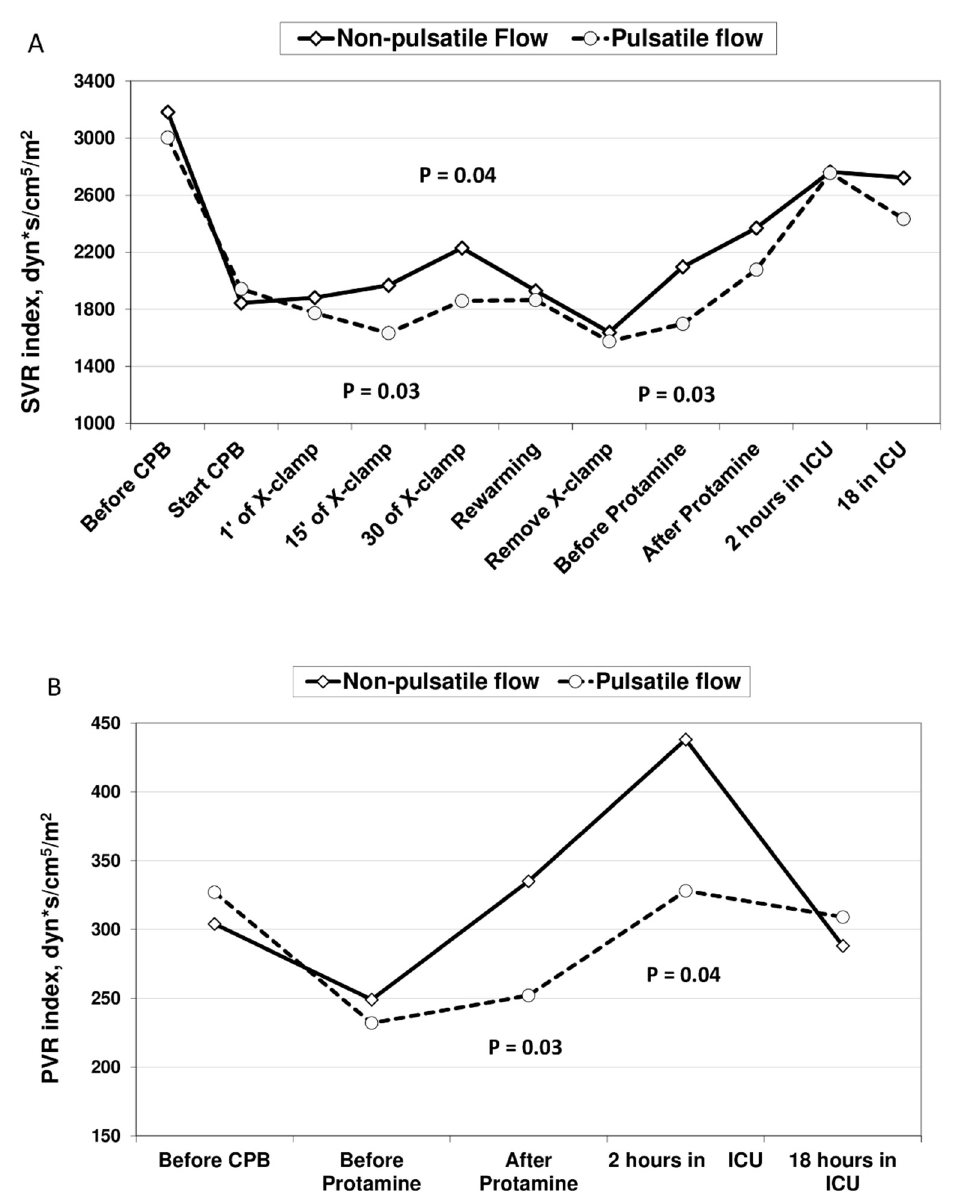
Figure 3. Perioperative profiles of indexed systemic (SVRi) and pulmonary (PVRi) vascular resistance. Panel ( A ) SVRi curve. Panel ( B ) PVRi curve.